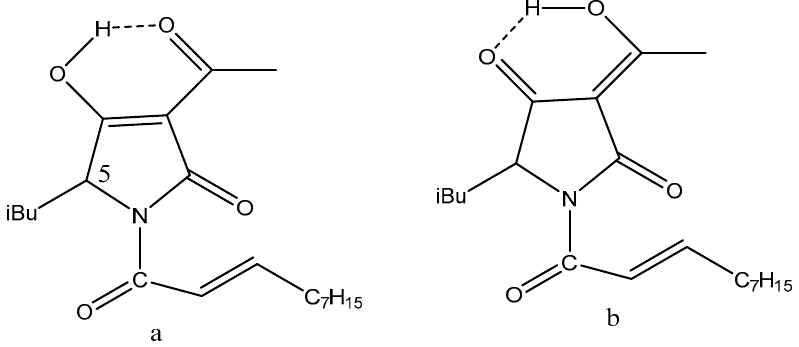
Figure 14. Tautomeric equilibria of 3-acyl tetronic (X=O) and tetramic (X=N) acids. (a-d) are the different enolic forms.